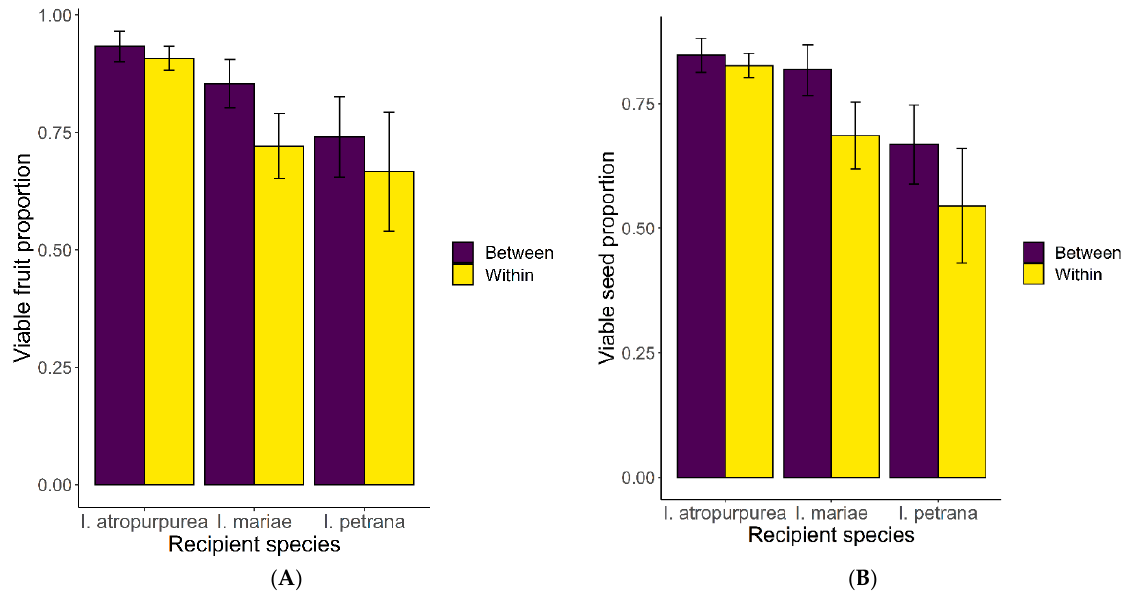
Figure 5. The proportion of viable fruits ( A ) and seeds ( B ) within (red) and between (grey) species crosses, in three recipient species. The differences between treatments were not significant ( p > 0.05) for all three recipient species.